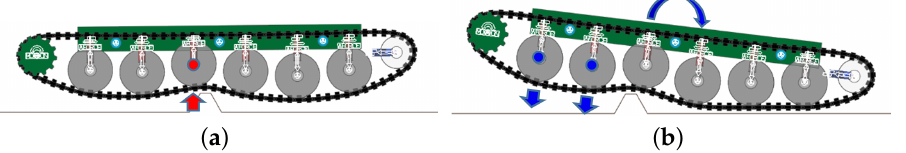
Figure 16. Suspension breakdown point: ( a ) Test 1 ( b ) Test